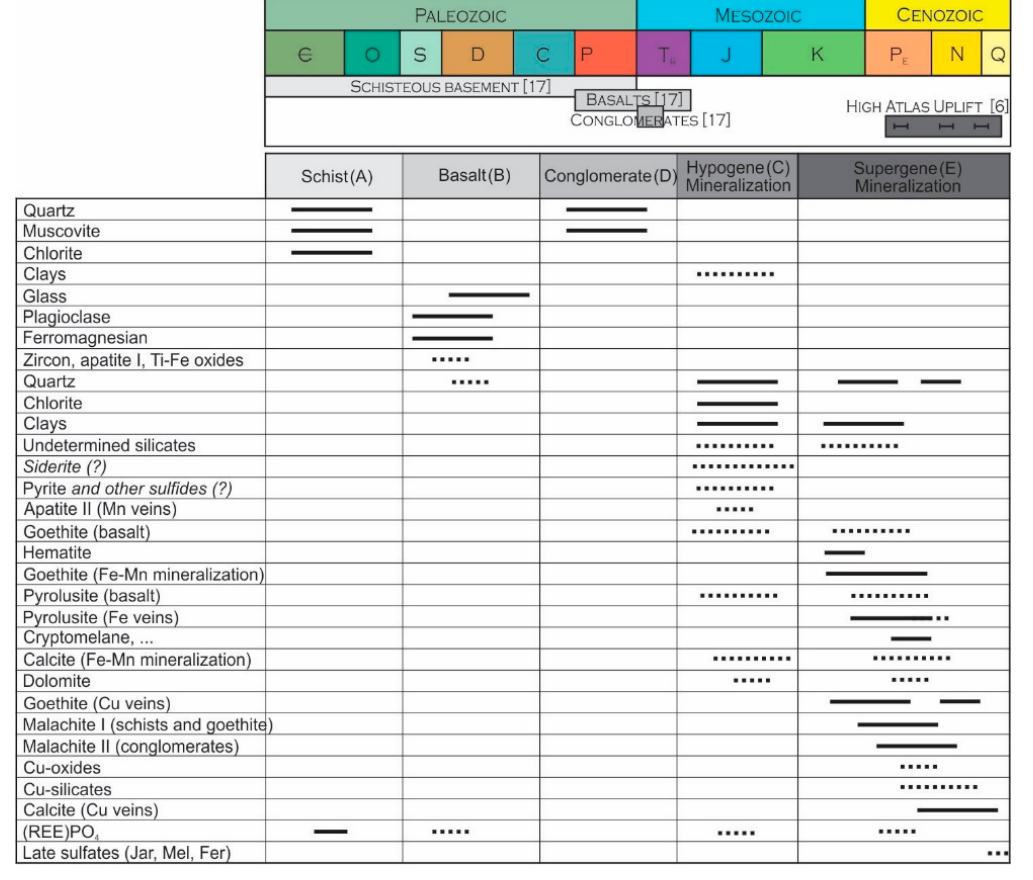
Figure 8. Paragenese of Jbel Rhals rocks and mineralizations, in relation to the evolution of the geological/geodynamical context: ( A ) formation of the Paleozoic schisteous basement; ( B ) Permo-Triasic basalts flow; ( C ) alteration of the host rocks, basalts, and formation of a hydrothermal ore; ( D ) Triassic conglomerates; ( E ) weathering probably related to the High Atlas Uplift. Relative ages of the formations are from [4], and of the High Atlas uplift from [6].